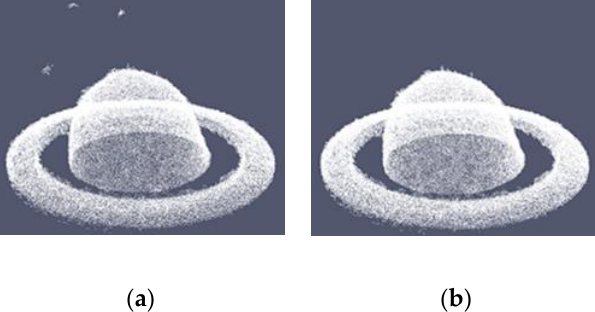
Figure A5. Example of outlier removal, after ellipsoidal point selection: ( a ) before, ( b ) after outlier removal: extracted point cloud for the test breast phantom B2.